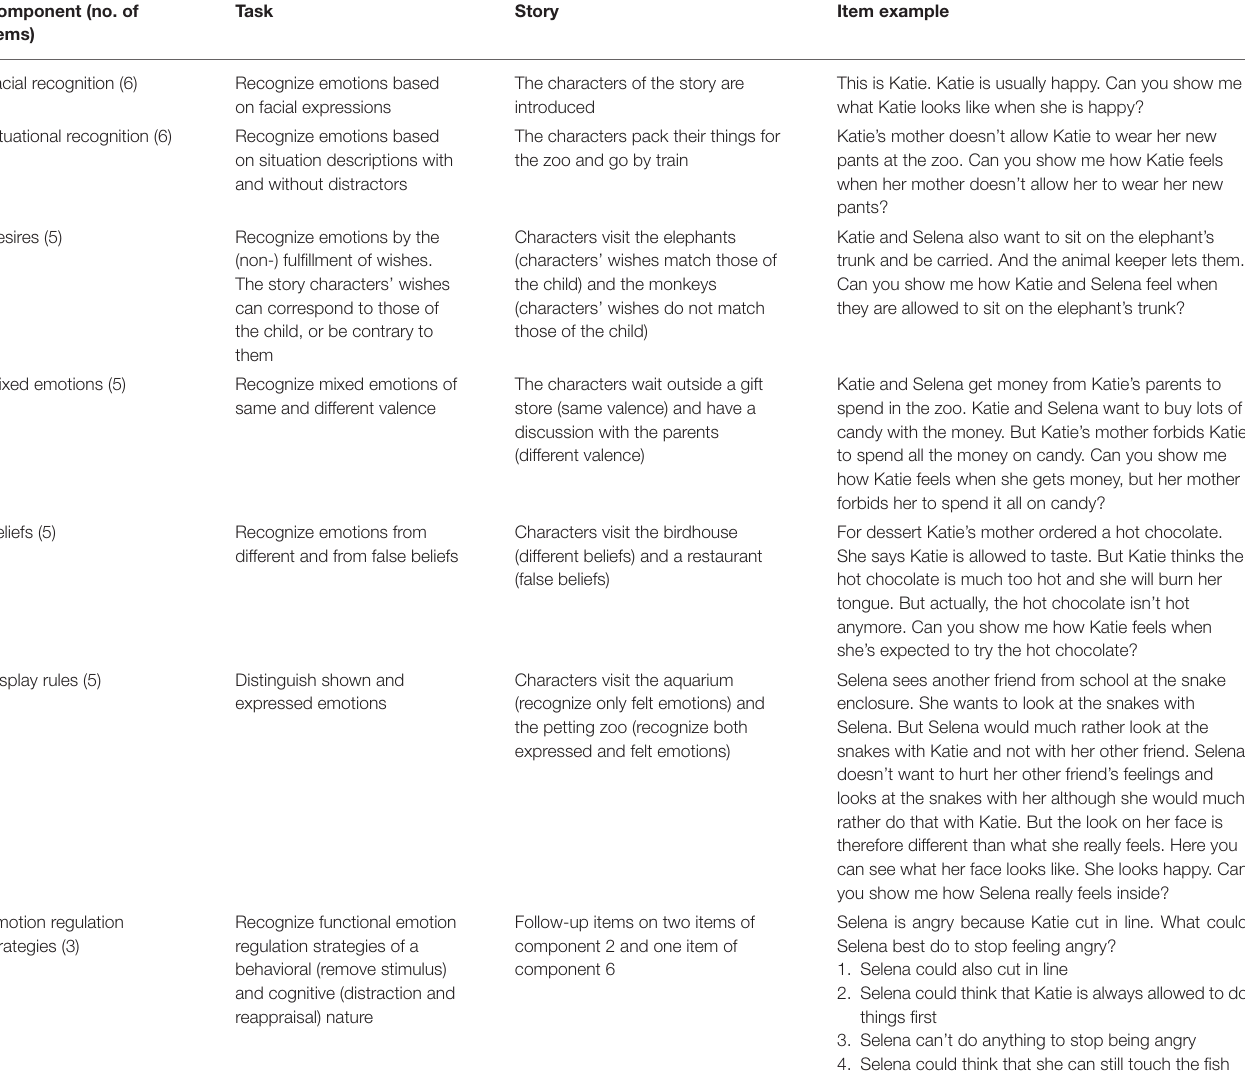
TABLE 2 | Components of the ATEM 3–9. Component (no. of